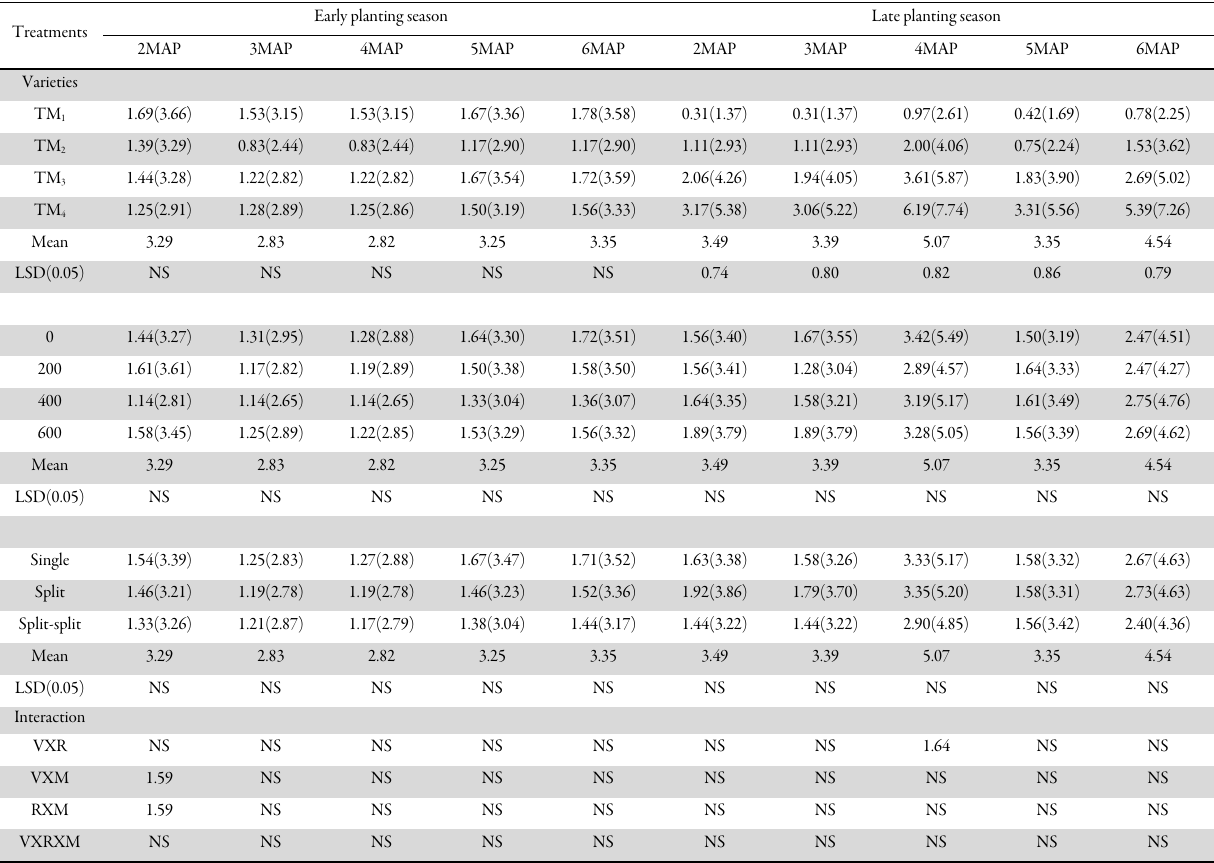
Table 5. Effect of varieties, rate, mode of NPK fertilizer and their interactions on the incidence of termites on the field